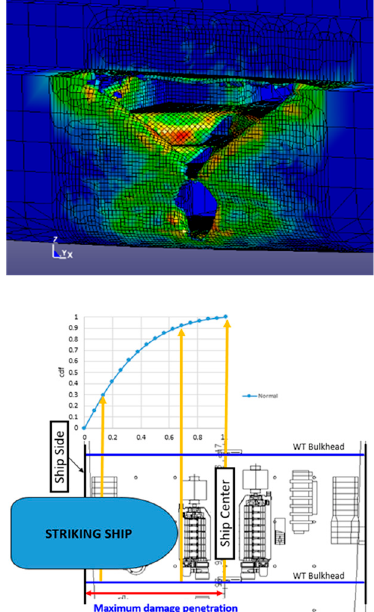
Figure 13. Crashworthiness analysis and double hull (B/10) for passive flooding protection.